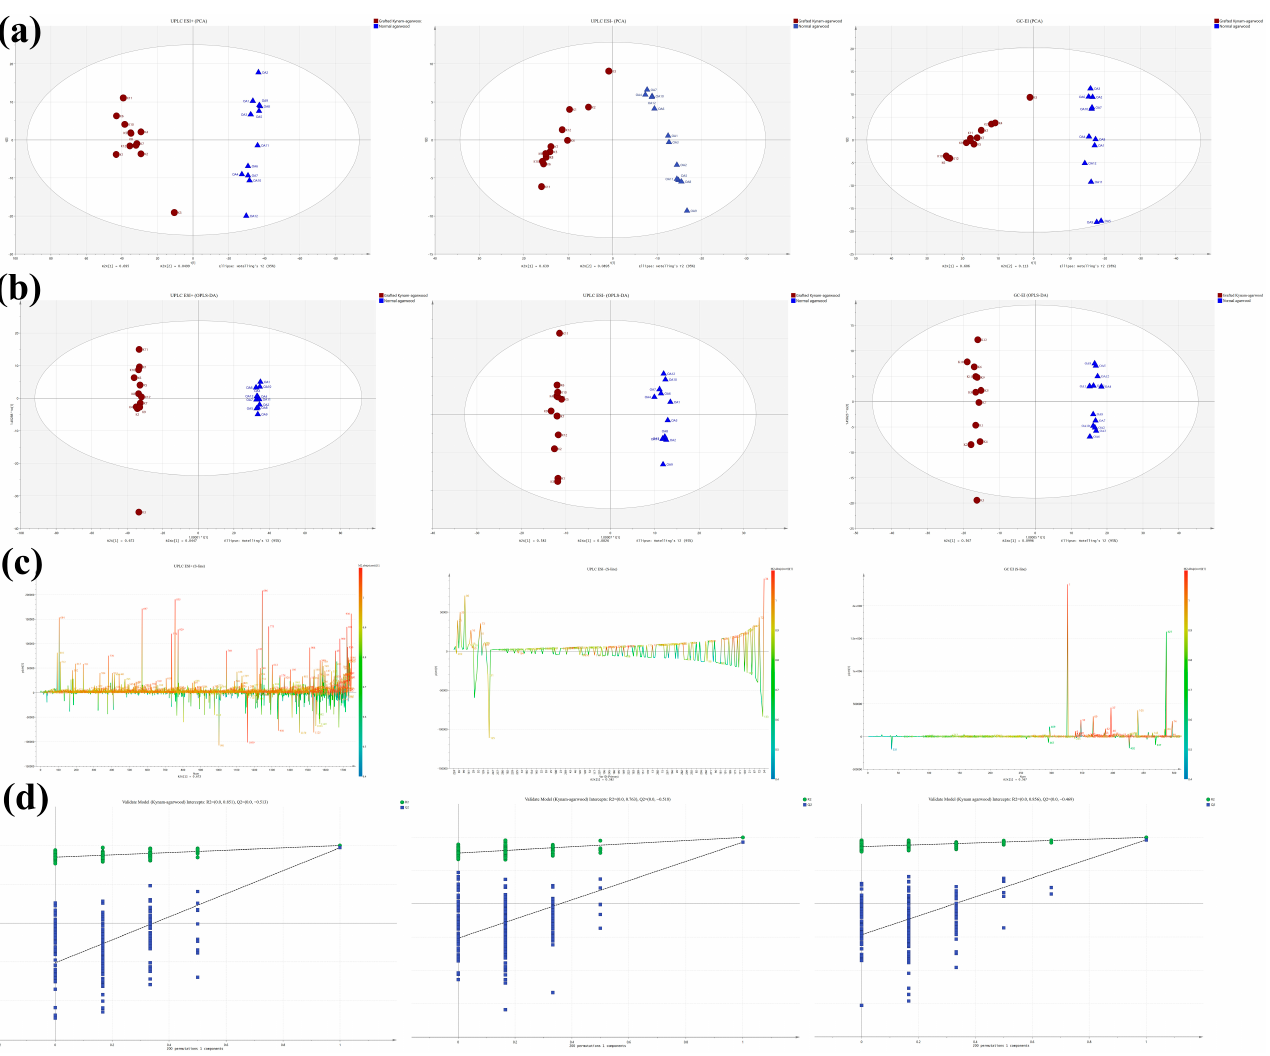
Figure 5. Multivariate statistical analysis revealed metabolic differences between the two types of agarwood. Score plot of the PCA model ( a ), score plot ( b ), S-line plot ( c ), and permutation analysis line plots ( d ) of the OPLS model. The numbers in the S-line plot are the codes for the ion features. The left, middle, and right columns are the multivariate statistical results obtained by GC-MS and UPLC/Q-TOF-MS positive and negative ion modes, respectively.